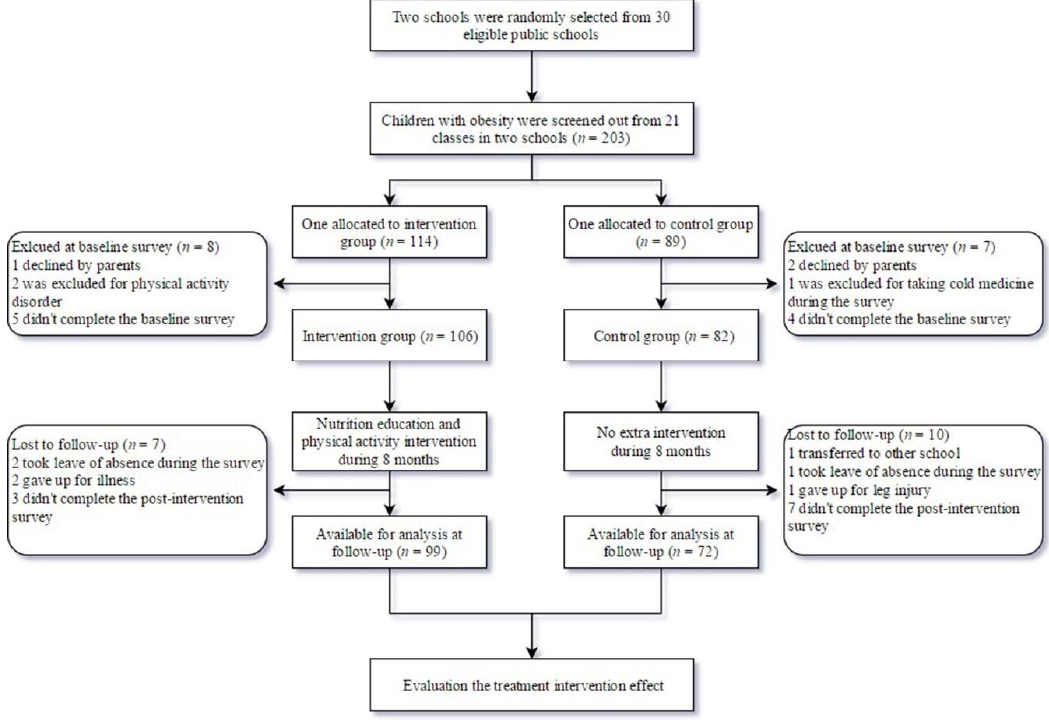
Figure 1. Participants flow diagram.